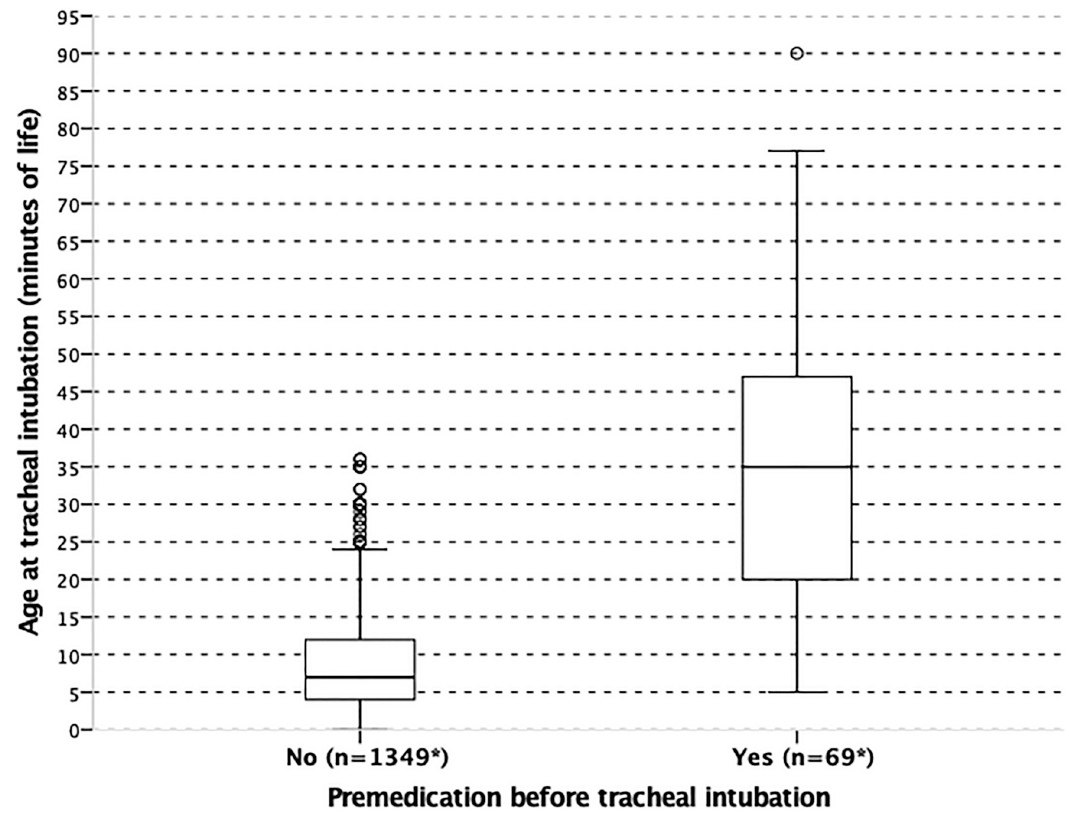
Fig 2. Distribution of age (minutes of life) at tracheal intubation in the delivery room according to premedication. Boxes represent values between the 1 st and the 3 rd quartile. The bar inside the box denotes median value. The adjacent values are the most extreme values within 1.5 inter-quartile range of the nearer quartile. All results (except n) are weighted to take into account differences in the sampling process between gestational age groups.